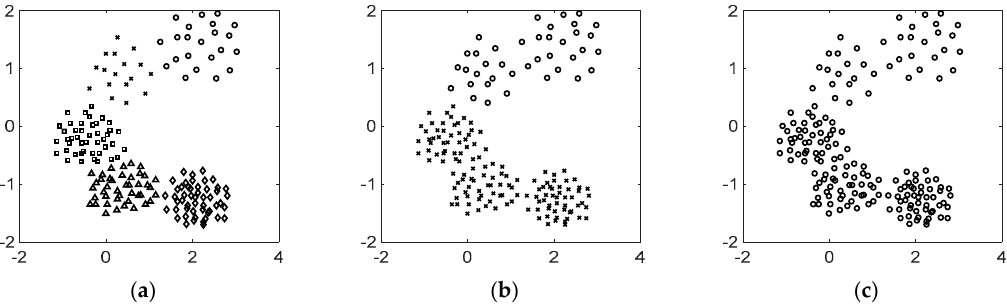
Figure 1. The number of clusters varies as ε increases: ( a ) five clusters; ( b ) two clusters; ( c ) one cluster.